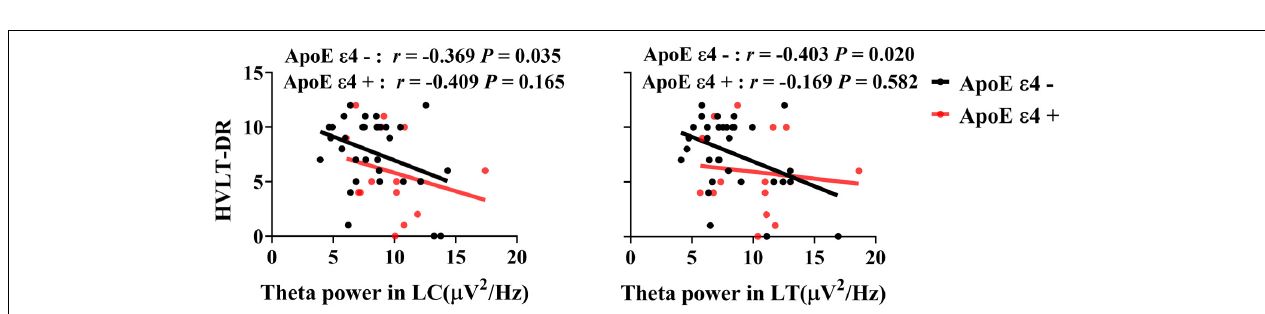
FIGURE 2 | Associations between the delayed recall performance and the resting theta power in the bilateral central and temporal regions in the elderly individuals without dementia ( R LC = − 0.358, P LC = 0.014, R RC = − 0.306, P RC = 0.036, R LT = − 0.337, P LT = 0.021, R RT = − 0.312, P RT = 0.033, FDR corrected). HVLT-DR, Hopkins Verbal Learning Test-Delayed Recall; LC, left central area; RC, right central area; LT, left temporal lobe; RT, right temporal lobe.